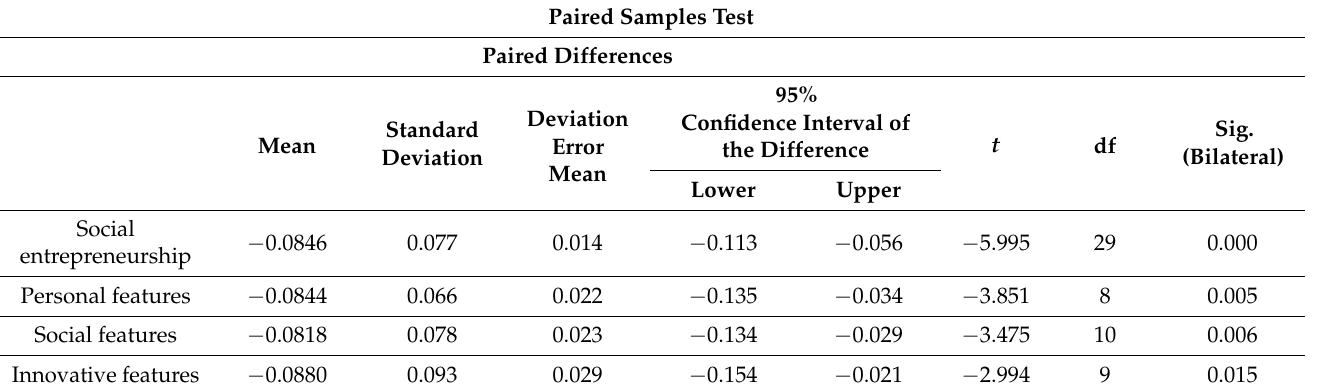
Table 2. Pre-test/post-test